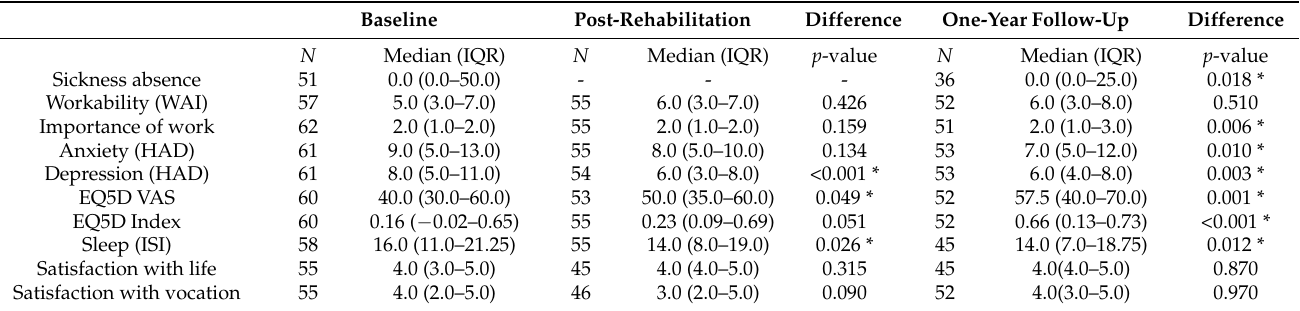
Table 3. Effects of participating in the interdisciplinary pain rehabilitation programme. Differences between baseline and post-rehab and baseline and one-year follow-up were analysed by Wilcoxon signed rank